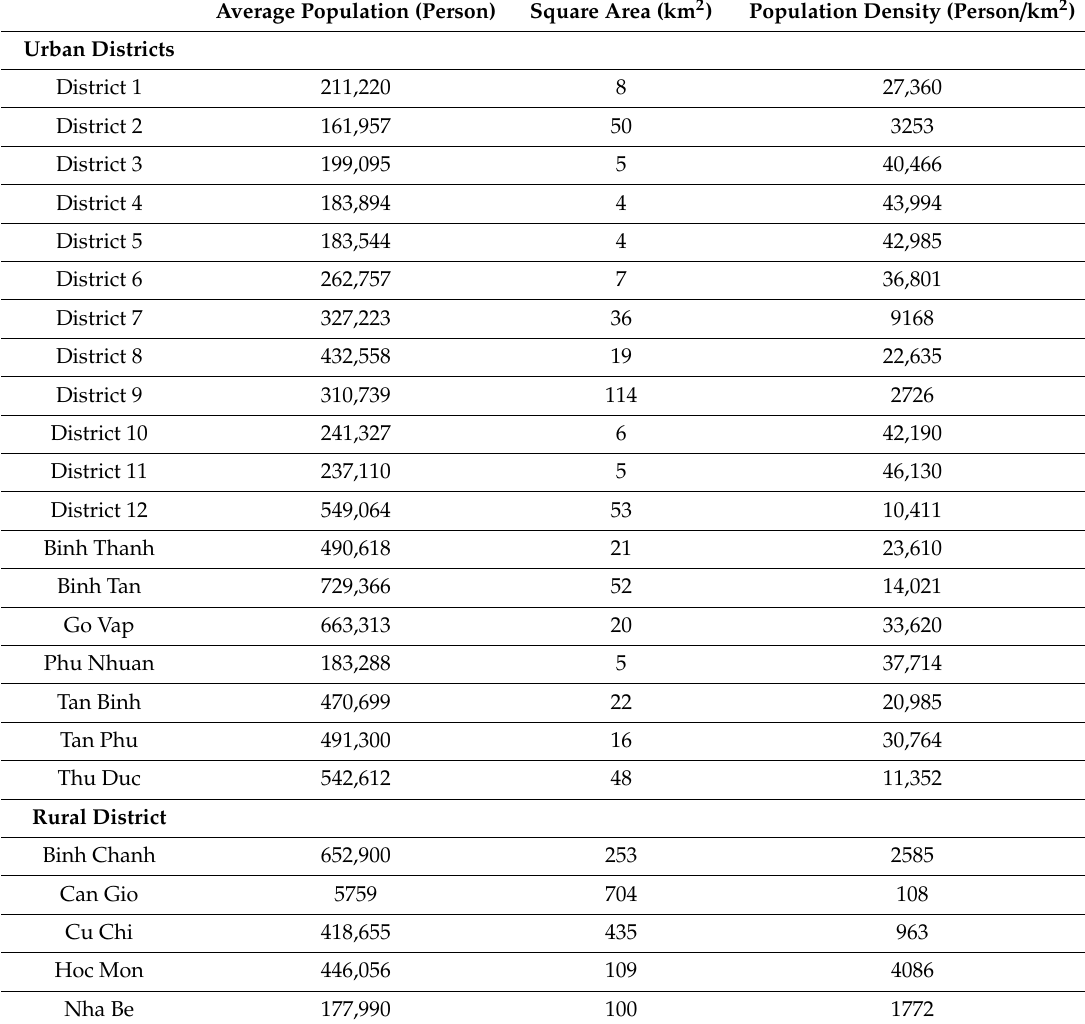
Table 6. Area, population and population density of HCMC in 2018 by District